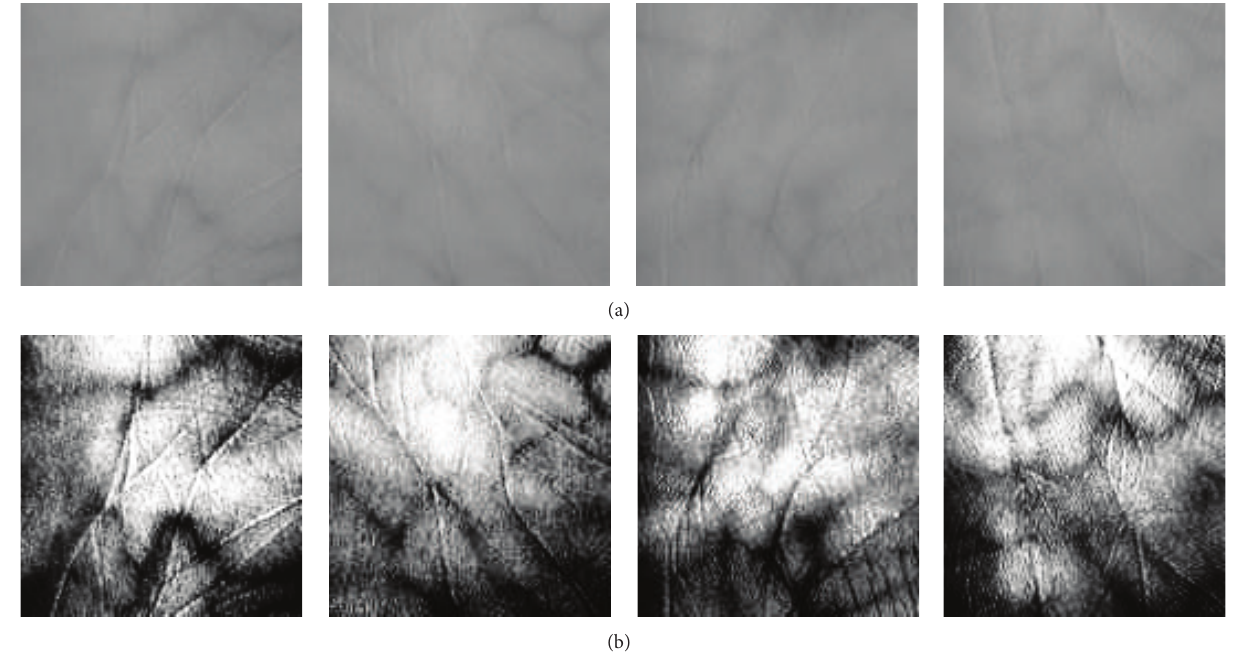
Figure 1: Image enhancement: (a) original ROI image; (b) enhanced image.